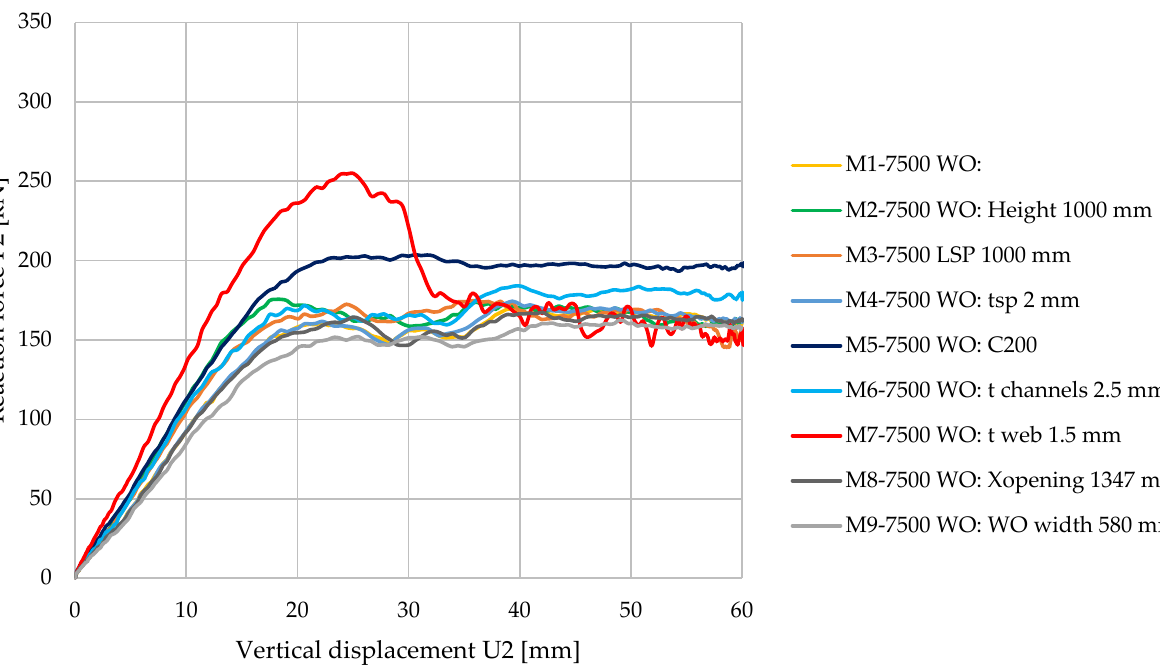
Figure 18. Parametric study for the beam with a web opening and a length of 7500 mm.